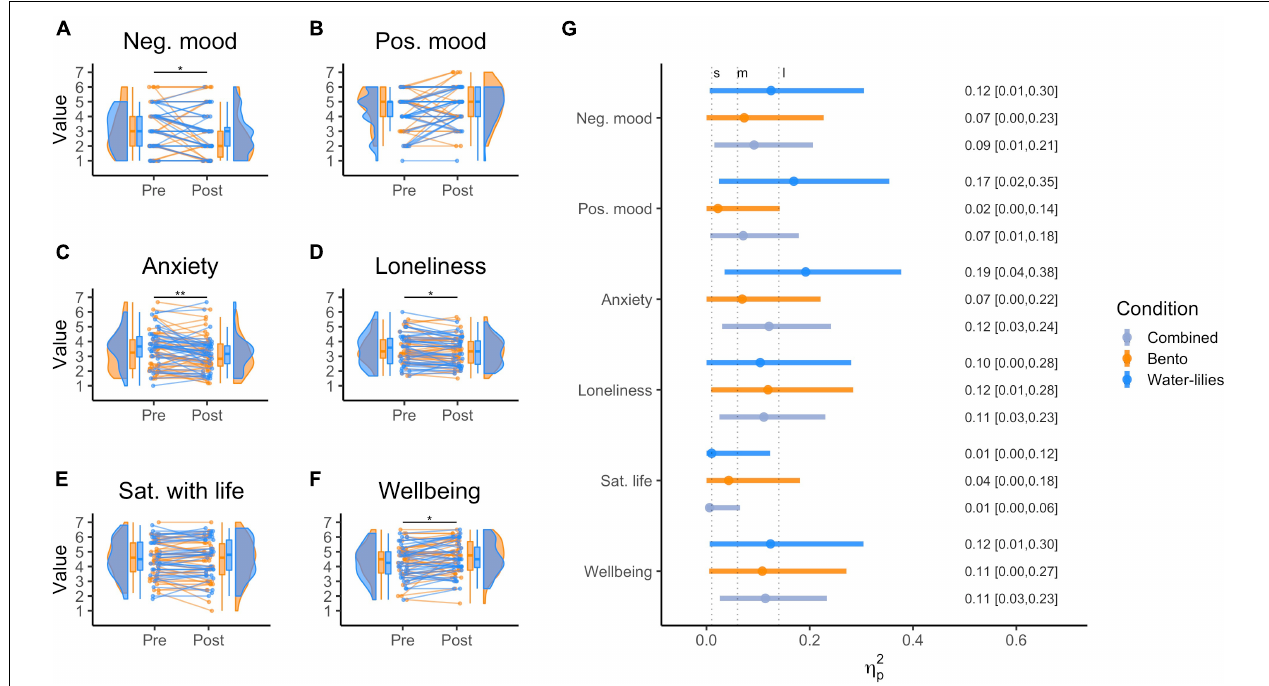
FIGURE 3 | (A–F) Raincloud plots showing the distributions of rating pre and post online cultural experience grouped by condition. The boxplots display the median (horizontal line middle of box), the data within the 25th and the 75th percentile (inside box), and the data within the 10th to the 25th and the 75th to the 90th percentile (vertical line); Dots represent individual ratings; Slopes represent changes between pre and post. Images were computed following Langen’s tutorial (Allen et al., 2021; see https://github.com/jorvlan/raincloudplots); (G) forest plot of the effect sizes (partial eta square) of the online experience on the six DVs. Vertical dashed lines are used to indicate intervals to interpret the strength of the effect. S, M, L indicate small, medium, and large effect size